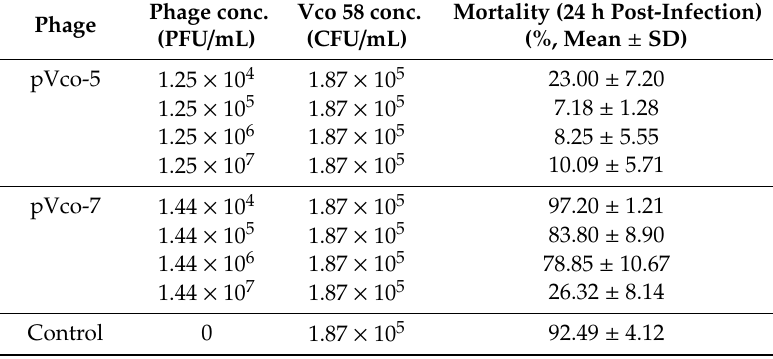
Table 2. Experimental Conditions and In Vivo Test Result of Prophylactic E ffi cacy of Pre-phage Treatment Against Vco 58